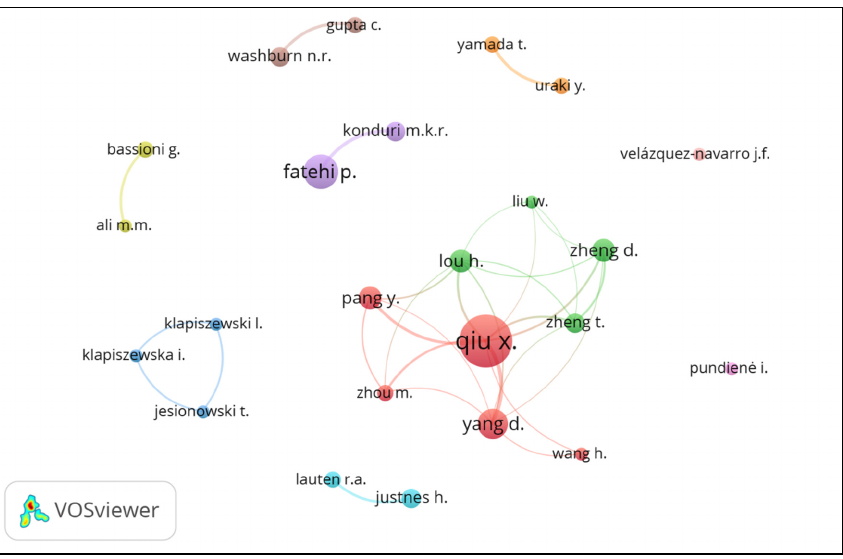
Figure 6. Co-authorship networks of collaborative scholars.